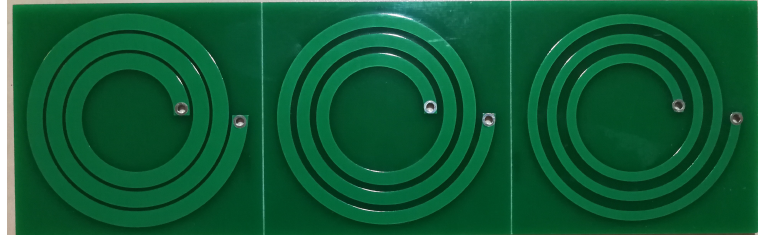
Figure 14. Group-1 prototypes with track width 5 mm ( left ), 4 mm ( middle ) and 3 mm ( right ).